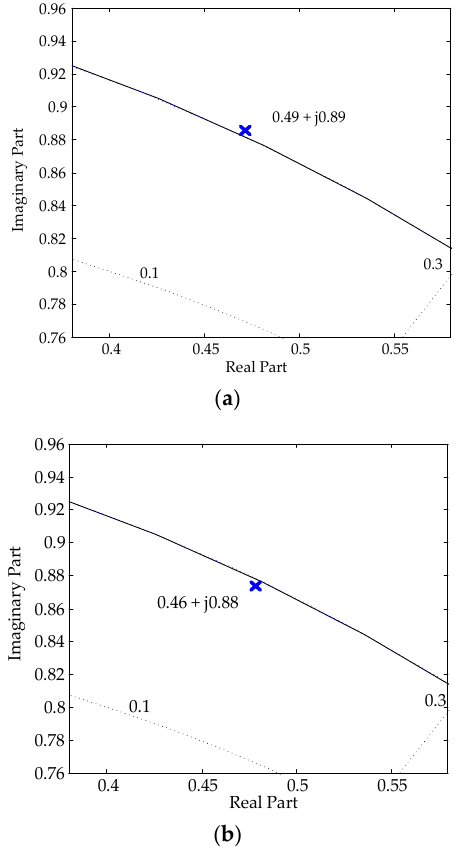
Figure 5. Z-domain analysis of the transfer from I g1 * to I g1 : ( a ) unstable ( b ) stable.